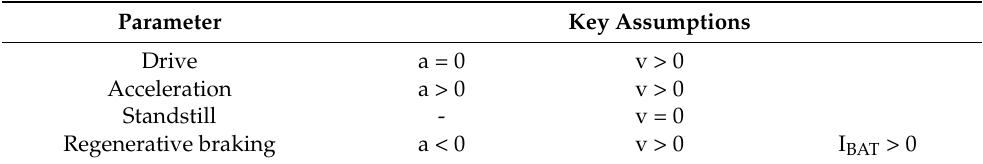
Table 5. Vehicle motion phase